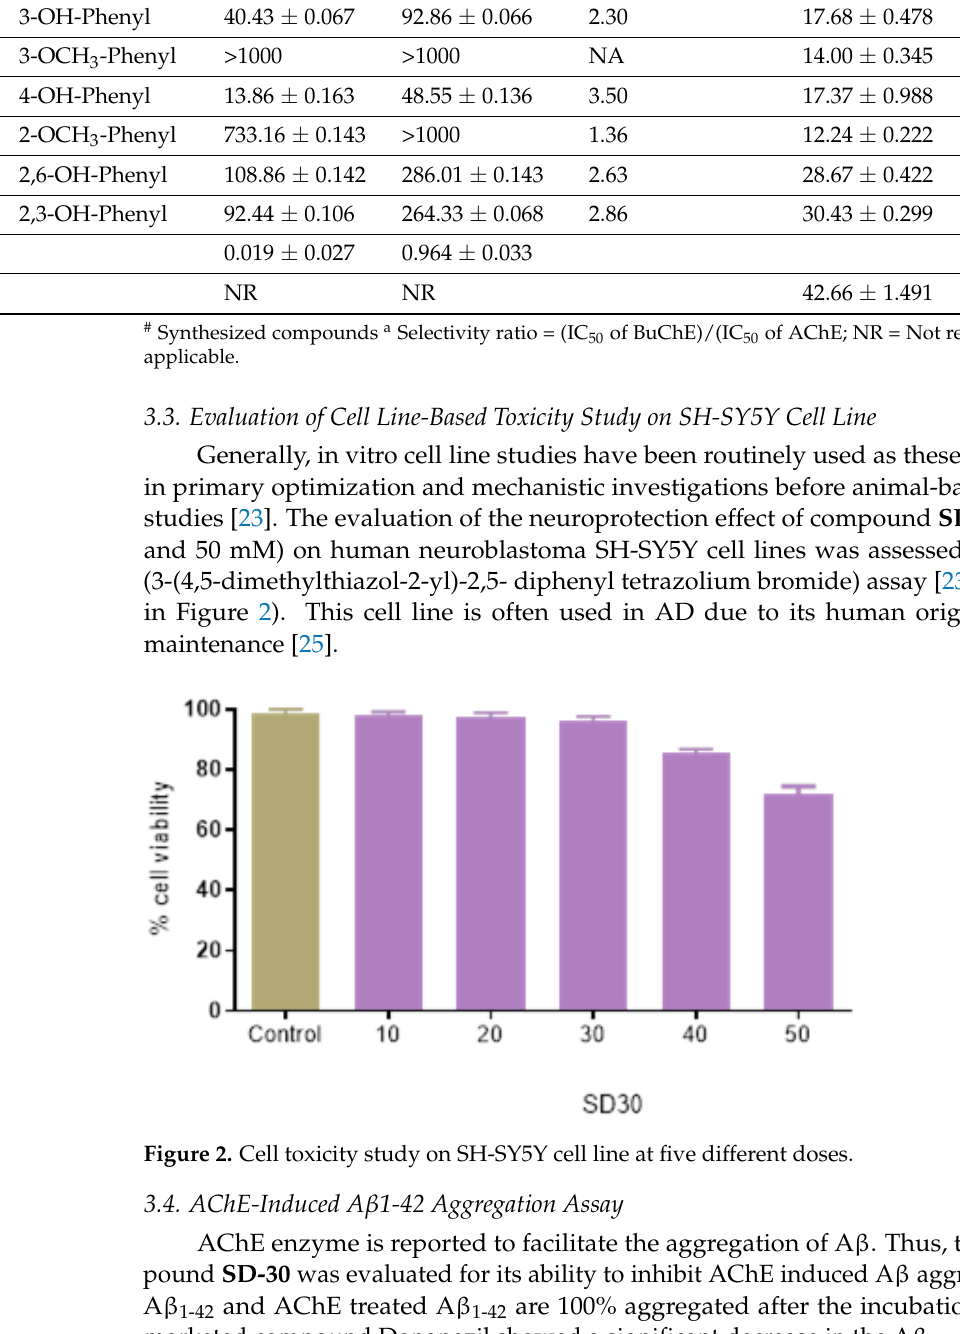
Figure 3. Effect of DNP, compound SD-30 on AChE induced A β aggregation: Donepezil (DNP) compound SD-30 showed a concentration-dependent decrease in the A β aggregation; AChE-in- duced the A β aggregation, and it is decreased by the DNP, compound SD-30.